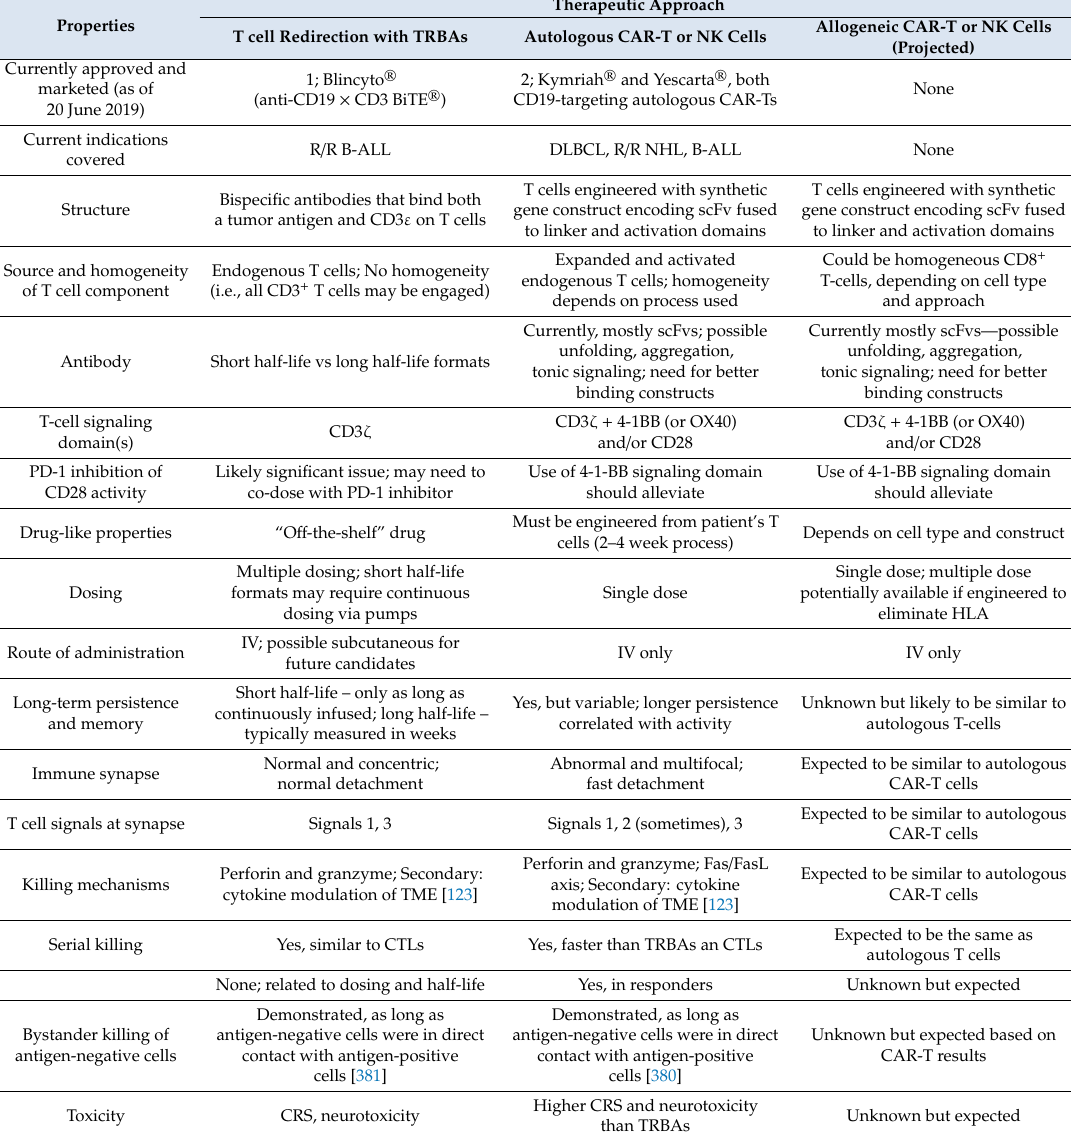
Table 6. Comparison of TRBAs and CAR-T cell platforms as